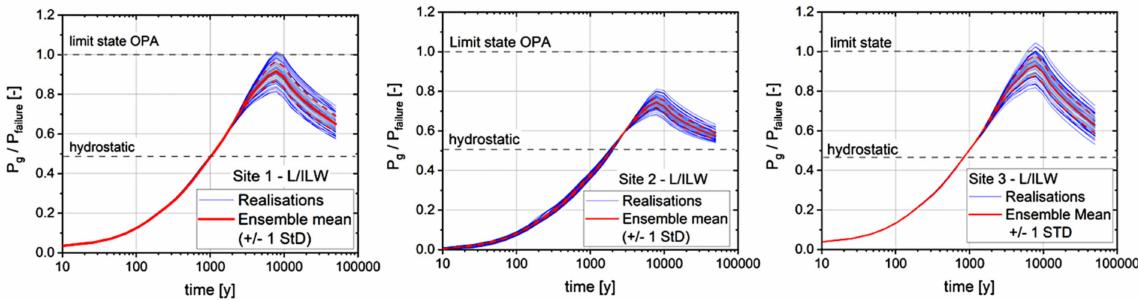
Figure 19. Long-term evolution of gas-induced pressures in the L/ILW repository: an example comparison between